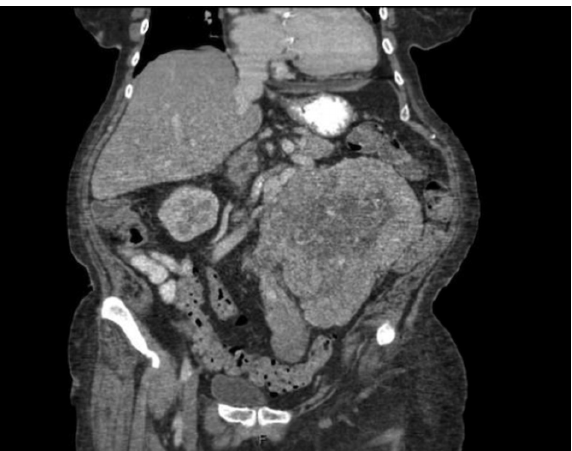
Figure 2: Axial view of computed tomography of the abdo- men and the pelvis revealing a heterogeneous appearance of the